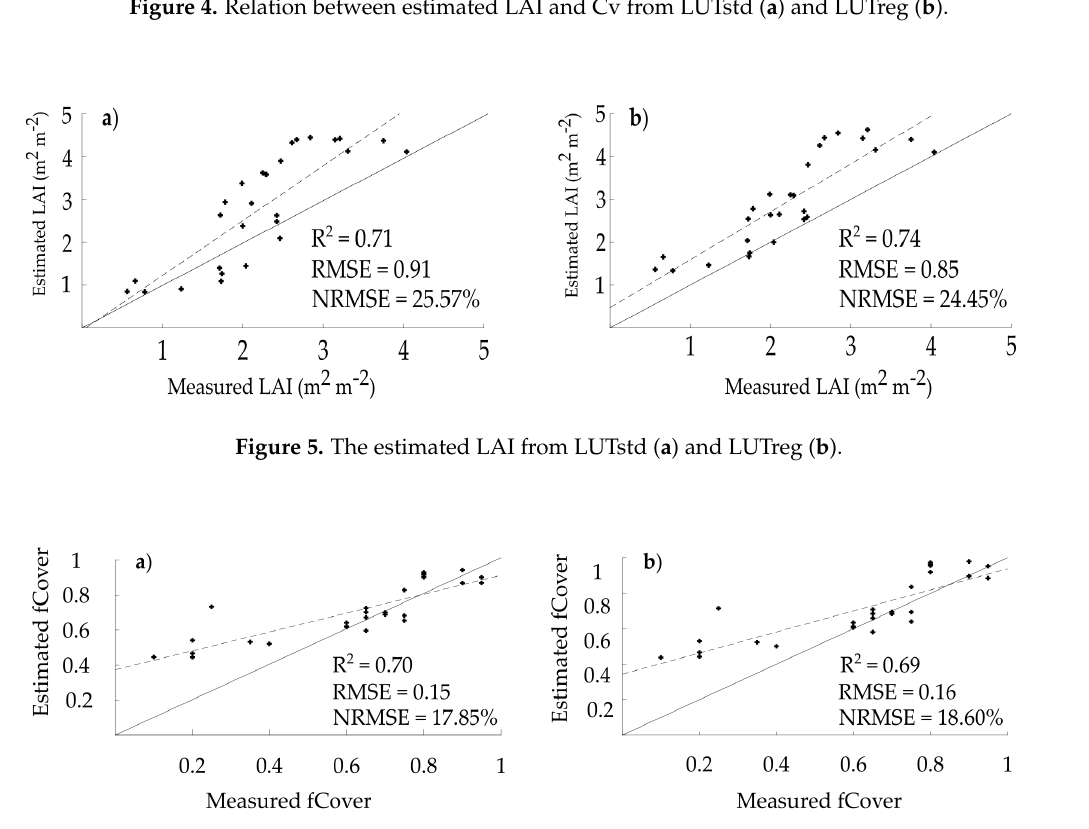
Figure 6. The estimated fCover from LUTstd ( a ) and LUTreg ( b